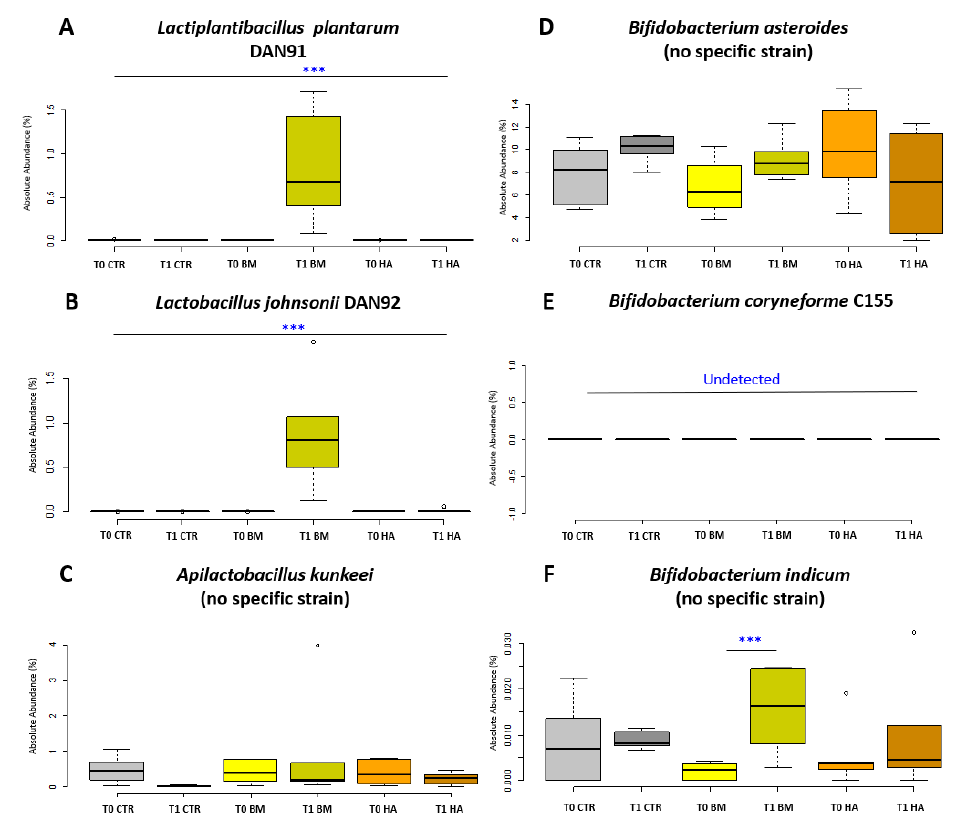
Figure 5. Absolute abundance of Bacteria Mixture in treated nucs. Box plots reporting the supplied microbial species composing the bacterial mixture, expressed for their absolute abundance in per- centage and in relation to experimental conditions (significant pairwise comparison *** p < 0.01). ( A ) Lactiplantibacillus plantarum Dan91, ( B ) Lactobacillus johnosonii Dan92, ( C ) Apilactobacillus kunkeei Dan39, ( D ) Bifidobacterium asteroides C3, ( E ) Bifidobacterium coryneforme C155, ( F ) Bifidobacterium in- dicum C499. Experimental conditions [CTR] Control, [BM] Bacterial Mixture and [HA] HiveAlive TM